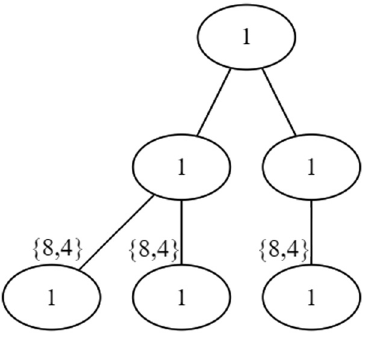
Figure 2: Tree directory for the Implementation of Step 2 ( ii ) , after assigning the fi rst three jobs of size 4.